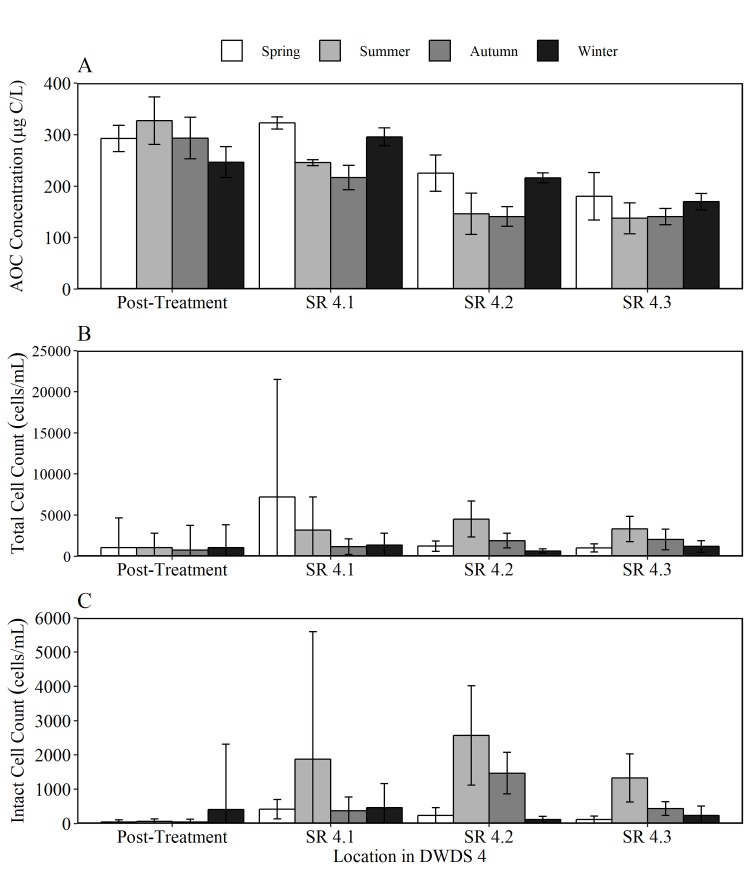
Seasonal water quality data for DWDS 4.Variation in the mean a) AOC concentration b) total cell counts (TCC) and c) intact cell counts (ICC) in post-treated water and three service reservoirs within the DWDS. Nb different y-axis scale for each parameter, and different y axis scales used in Fig 9, Fig 10 and Fig 11. Data was split into spring, summer, autumn and winter seasons based on monthly averages in temperature.